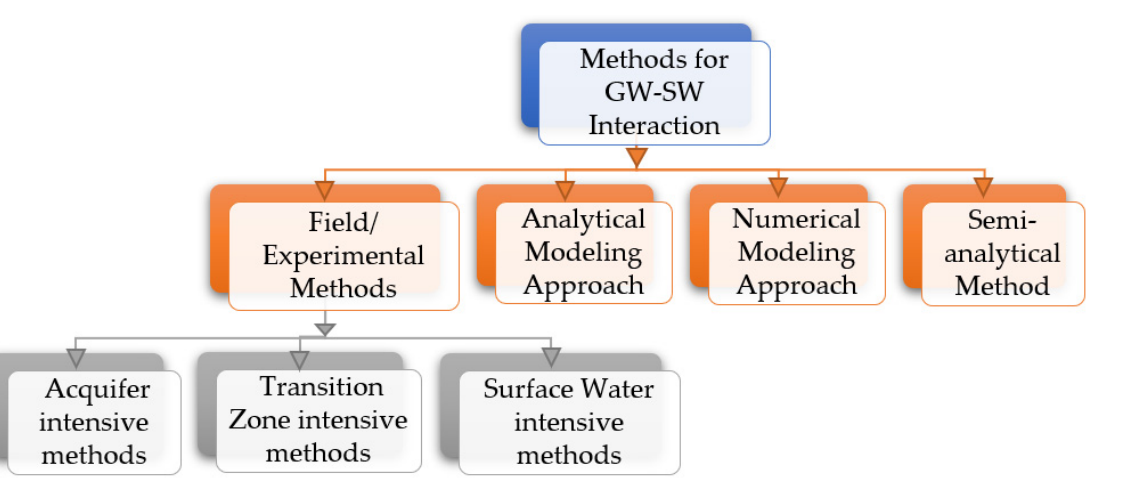
Figure 7. Methods for analyzing groundwater (GW) and surface water (SW) interactions.